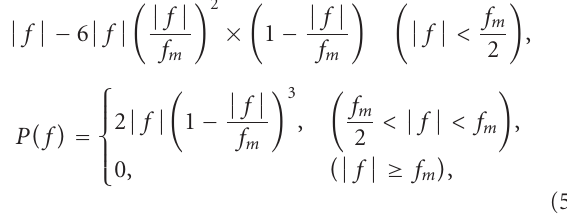
Figure 6: Shepp-Logan, Butterworth, Hann, Parzen filter func- tions’. (from Van Laere et al., (2001), modified )